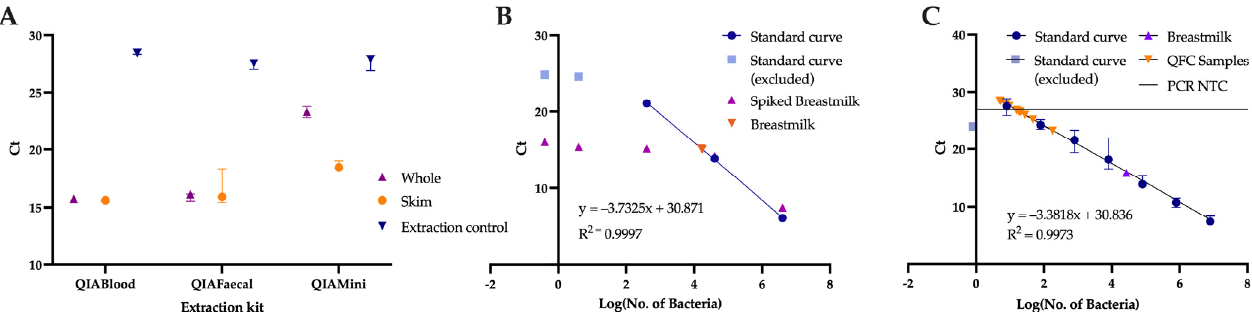
Figure 2. ( A ) Comparison of extraction kits from whole and skim milk. Icon represents median, and error bar represents range of triplicate technical replicates. ( B ) Cycle threshold (C T ) vs. Log(No. of Bacteria) for testing of extraction efficiency from bacteria in PBS (Standard curve) vs. in breastmilk (Spiked breastmilk). For all but breastmilk (orange inverted triangle) icon represents median of technical triplicates; however, range was too small to display. Median only displayed for test breastmilk sample for ease of viewing. ( C ) Cycle threshold (C T ) vs. Log(No. of Bacteria) for quantification of bacterial load of QFC breastmilk samples. Icon and error bars represent median and range for standard curve. Orange icons are the median values of the QFC samples (n = 16) with Log(No. of Bacteria) calculated from C T